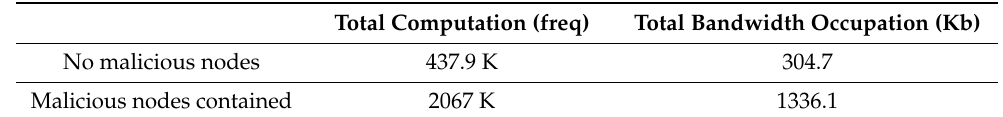
Figure 8. Resource occupation of the RAFT algorithm with no malicious nodes.